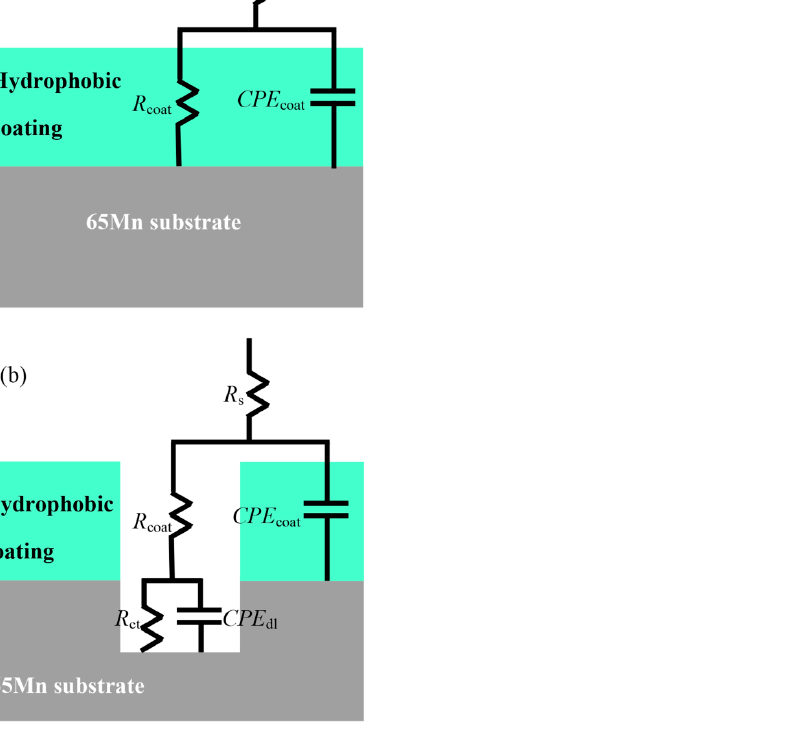
Figure 9. Equivalent circuit models used for numerical fitting of the coated samples during different immersion periods in 3.5 wt.% NaCl: ( a ) 1 h to 12 h for HC-30, ( b ) 1 h to 24 h for HC-15 and HC-60, 16 h to 24 h for HC-30.